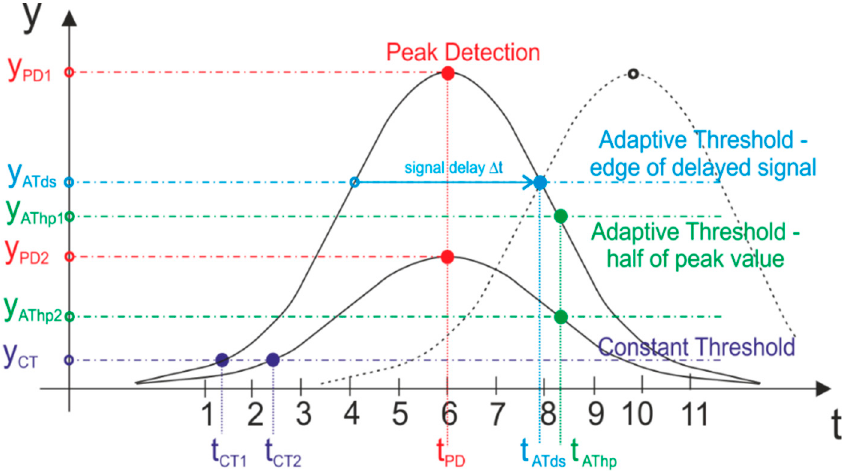
Figure 1. Characteristic points of the waveform of Gaussian curve modeling the echo signal of a laser pulse and names of methods based on their detection.